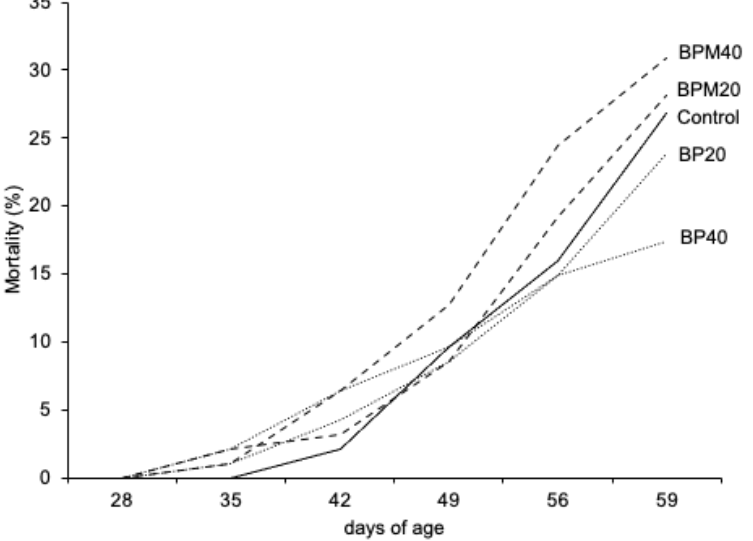
Figure 1. Evolution of mortality of growing rabbits during the fattening period as a function of the